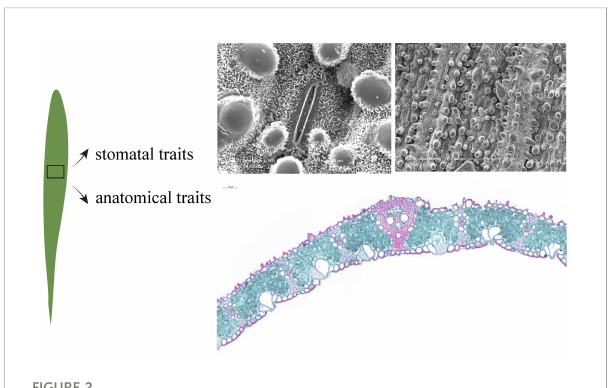
FIGURE 2 Images of leaf stomata and anatomy.